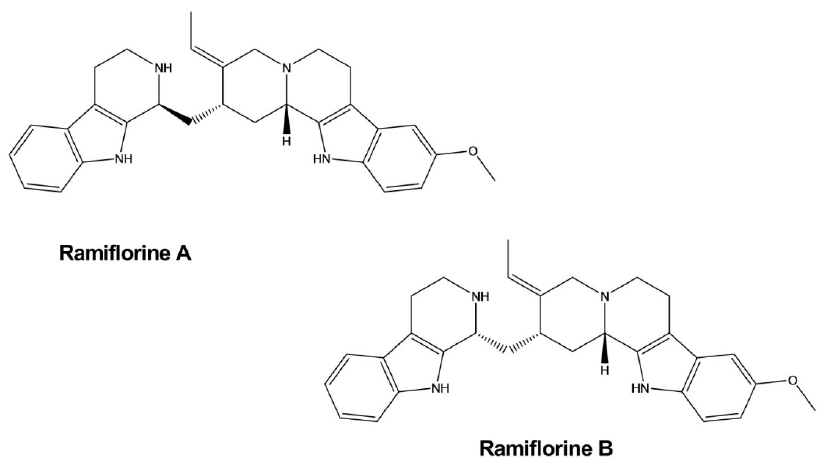
Figure 16. Antileishmanial activity of indole alkaloids.